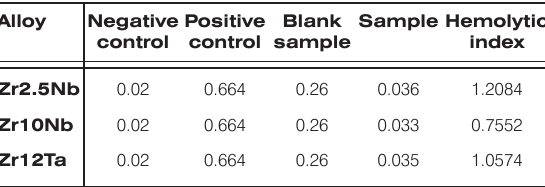
Table 2. The blank corrected hemolytic index.